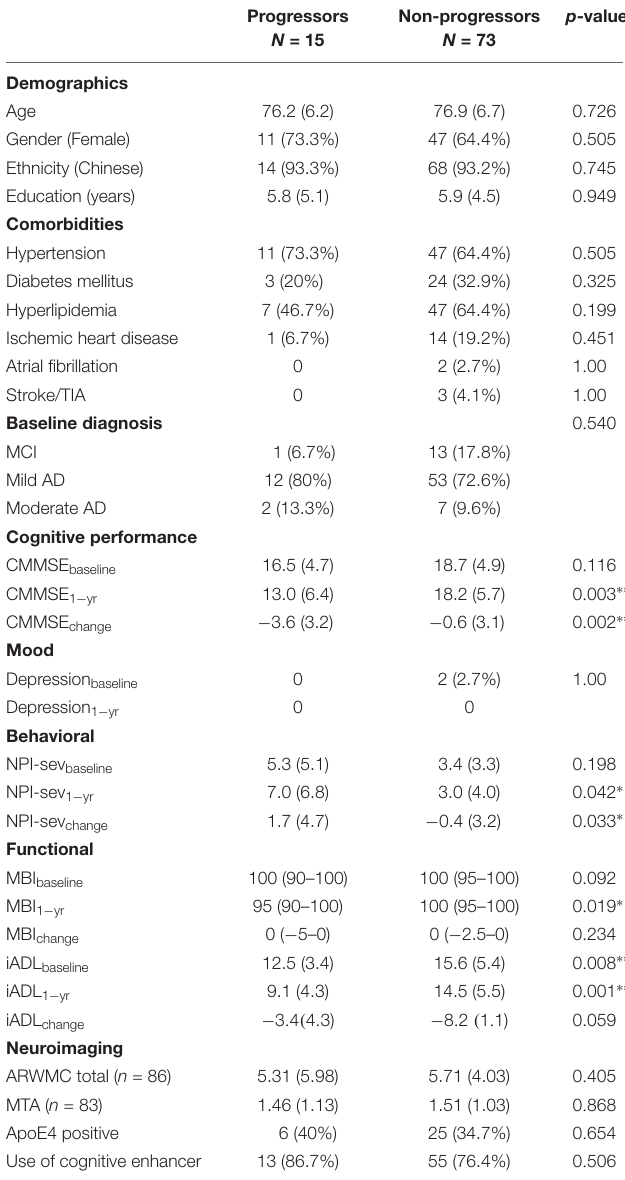
TABLE 1 | Clinical characteristics and disease